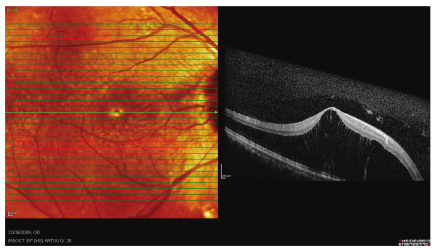
Figure 3: Spectralis OCT showing severe cystoid macular edema with di ff use inner retinal layer thickening in the foveal cut.